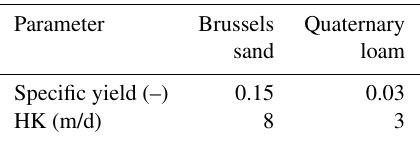
Table 2. Hydraulic conductivity and storage parameter value of the two geological settings after calibration.